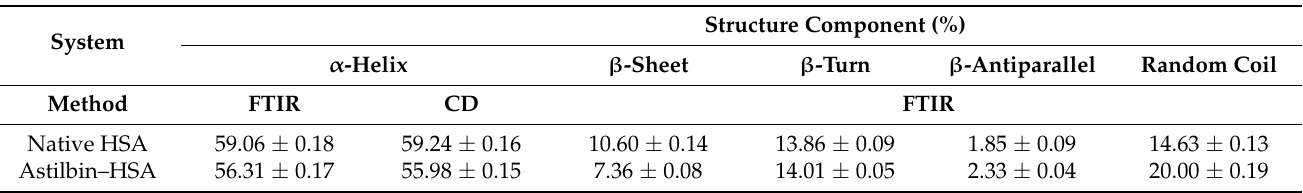
Table 5. Secondary structure contents analysis of HSA and astilbin − HSA